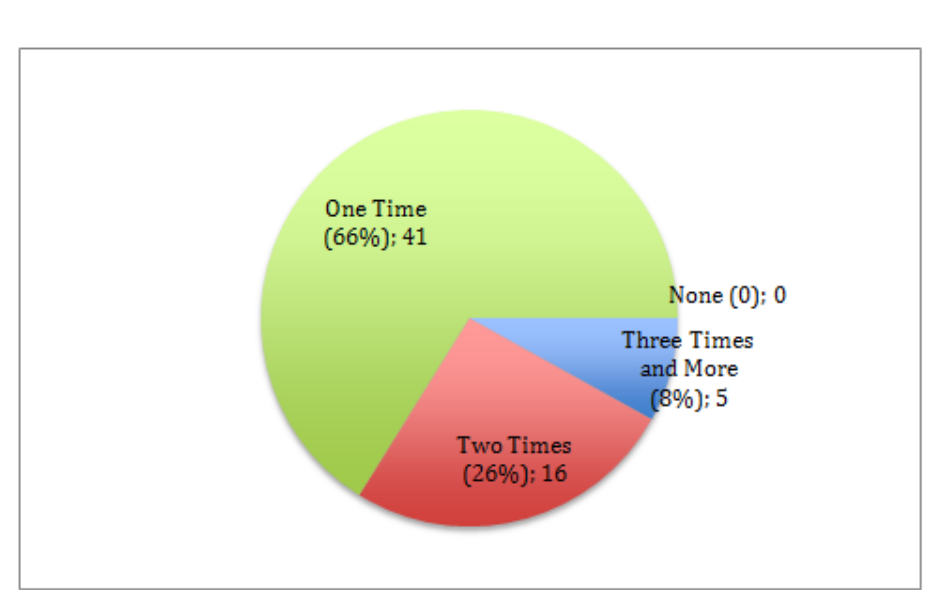
Figure 6. How many times students have watched the